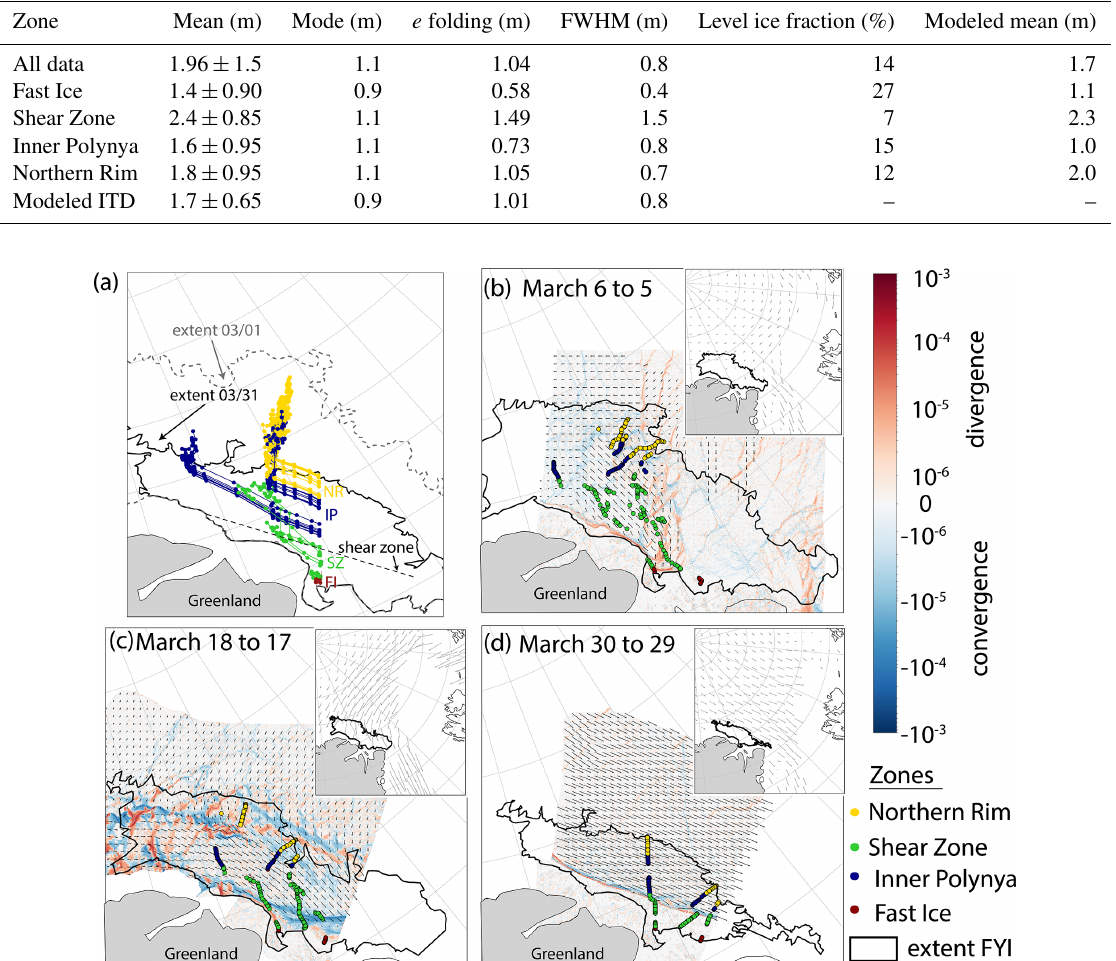
Figure 7. Trajectories, drift, and deformation during the three main deformation phases. (a) Example of trajectories initialized on the northern profile. Their colors indicate the zone in which they end. (b, c, d) Snapshots of divergence (red), convergence (blue), and drift (arrows) within the FYI area during the three main deformation phases. The density and length of arrows indicate the magnitude of drift. Colored dots mark the location of the trajectories at the respective time. The insets show the average, large-scale drift of a 48h period covering the indicated time (arrows, low-resolution drift, OSI SAF, OSI-405-c; see “Data availability” at the end of the text) linked to the local deformation within the